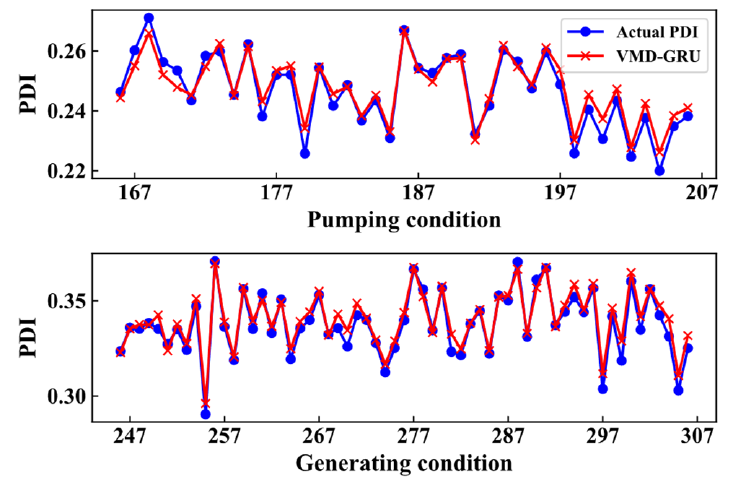
Figure 14. Performance of VMD-GRU.